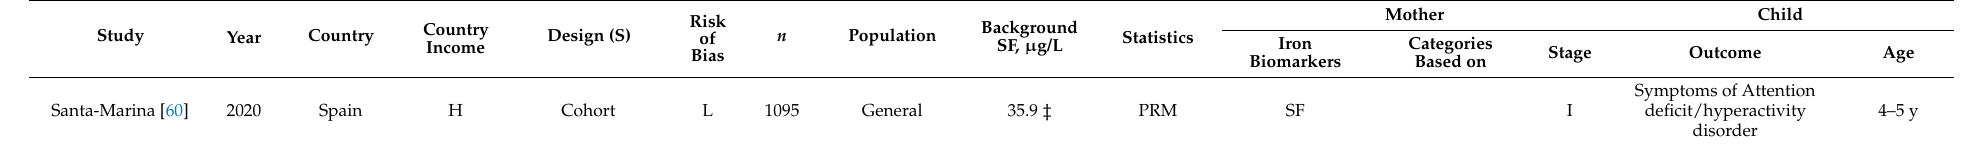
Table 4. Studies on maternal iron status and other child outcomes after birth.